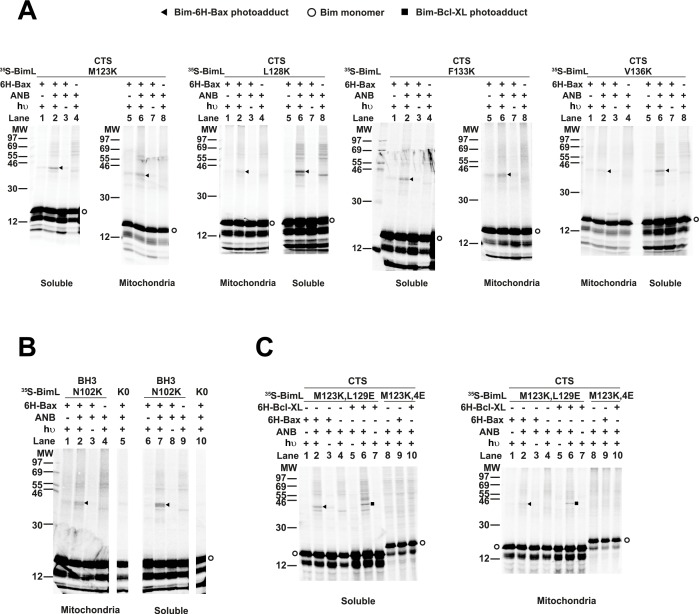
Residues within the Bim CTS interact with Bax.(A) Interaction of the Bim CTS with Bax in both soluble and mitochondrial fractions detected by photocrosslinking. The [35S]Met-labeled BimL proteins, each with a single εANB-lysine residue located at the position in the CTS indicated at the top of the panels, were synthesized in vitro, and incubated with His6-tagged Bax protein (6H-Bax) in the presence of mitochondria lacking endogenous Bax and Bak. The mitochondria were then separated from the soluble proteins by centrifugation and both fractions were photolyzed. The resulting radioactive BimL/6H-Bax photoadducts were enriched with Ni2+-beads, and analyzed by SDS-PAGE and phosphor-imaging. BimL/6H-Bax dimer specific photoadducts were detected in both mitochondrial and soluble fractions and indicated by arrowheads. They were of reduced intensity or not detected in control incubations in which the ANB probe, light (hυ)or 6H-Bax protein was omitted, as indicated. The radioactive BimL monomers are indicated by circles. The migration positions of protein standards are indicated by molecular weight (MW) in kDa. (B) Interaction of the Bim BH3-domain with Bax in both soluble and mitochondrial fractions detected by photocrosslinking. As a positive control experiment illustrating the expected efficiency for the photocrosslinking of BimL protein with a single εANB-lysine located at the indicated position in the BH3-domain was used to photocrosslink 6H-Bax protein. In another control experiment, a lysine-null BimL protein that does not contain any εANB-Lys (K0) was used. As expected, a BimL/6H-Bax specific photoadduct was detected in the former but not the latter experiment. And, the efficiencies for the photocrosslinking via photoprobes located in the BH3-domain (B) and the CTS (A) are comparable strongly suggesting that like BH3-domain, the CTS interacts with Bax directly. (C) The 4E mutation in the BH3-domain but not the L129E mutation in the CTS of Bim inhibited photocrosslinking of the Bim CTS to Bax. The BimL protein with either the 4E or the L129E mutation and the εANB-Lys in the CTS was used in the photocrosslinking reaction with either 6H-Bax or 6H-Bcl-XL protein in both soluble and mitochondrial fractions. While the L129E mutation did not inhibit photocrosslinking of BimL to either 6H-protein, the4E mutation did. The BimL/6H-Bcl-XL photoadducts are indicated by squares. The phosphorimages in all panels are representatives from two independent photocrosslinking experiments with each indicated pair of BimL and 6H-Bax or 6H-Bcl-XL proteins.